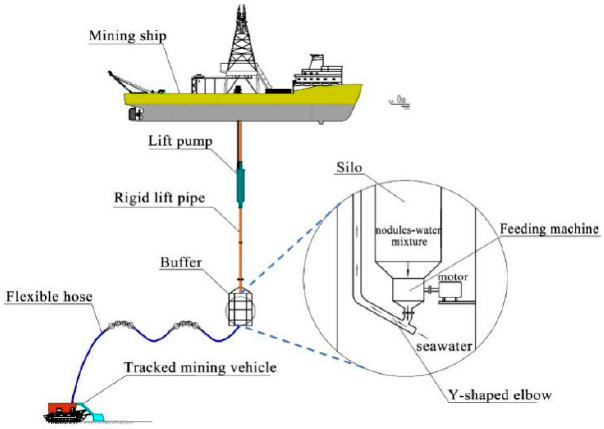
Figure 1. Schematic diagram of deep-sea mining system and Y-shaped elbow.